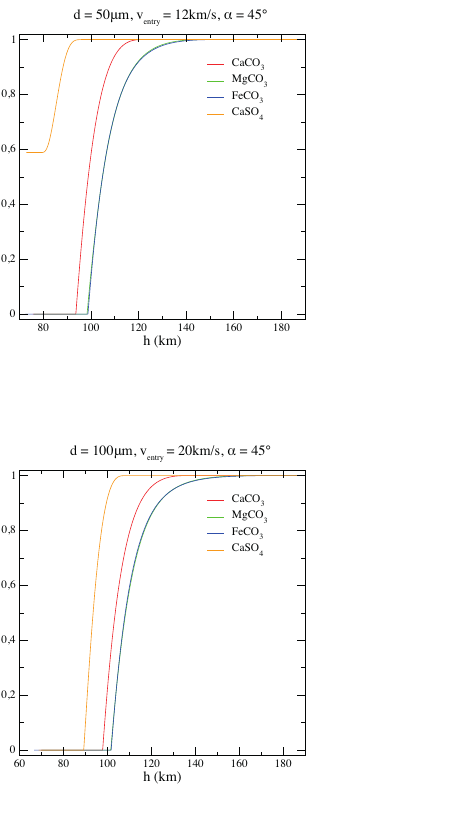
Figure 3. Carbonate/sulphate fraction χ of the corresponding entry scenarios of MgCO 3 , CaCO 3 , FeCO 3 , and CaSO 4 micrograins for various diameters ( d ), velocities (v entry ), and entry angles ( α ) of the